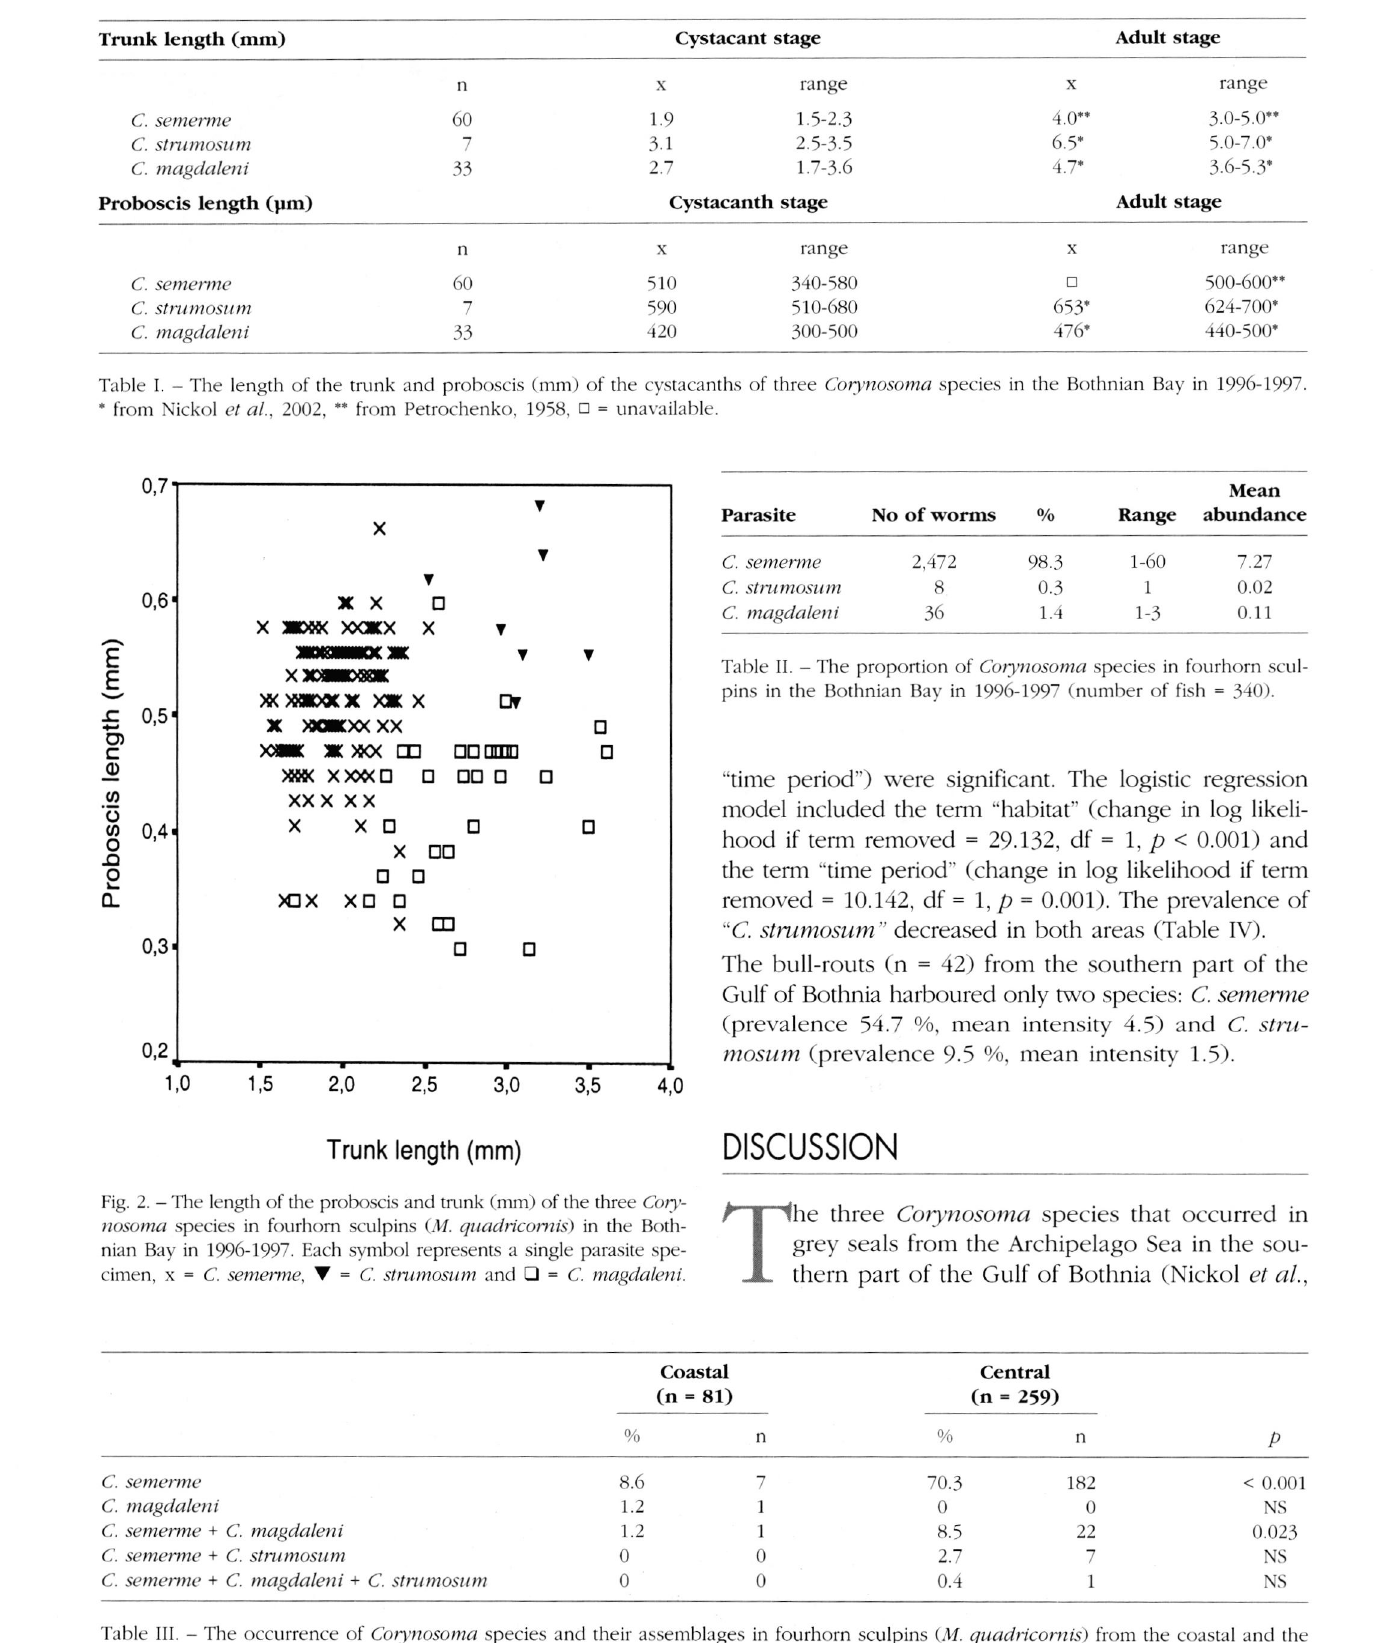
Table III. - The occurrence of Corynosoma species and their assemblages in fourhorn sculpins (M. quadricornis) from the coastal and the central areas of the Bothnian Bay in 1996-1997. The frequences of the Corynosoma assemblages were tested by Pearson x 2 -test and its significance level (p) are